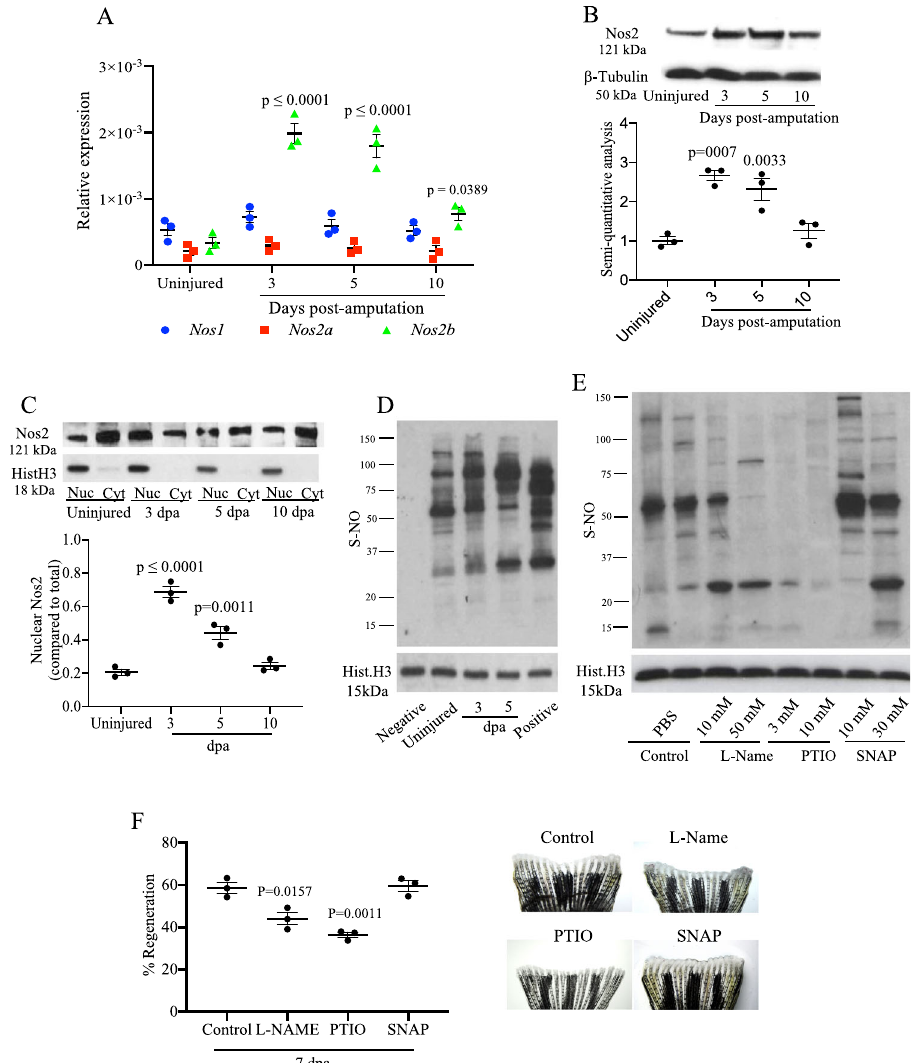
Fig. 1 Modulation of Nos and nuclear protein S-nitrosylation during tail fi n regeneration in adult zebra fi sh. A Real time PCR for nos1 , nos2a , and nos2b in tail fi n at 3, 5, and 10 dpa. B Western blot (WB) analysis of Nos2 in tail fi ns at 3, 5, and 10 dpa and semi-quantitative analysis of bands. C WB analysis of Nos2 in nucleus and cytoplasm of tail fi ns at 3, 5, and 10 dpa. Semi-quantitative analysis of bands shows nuclear to cytoplasmic protein ratio. D WB analysis of S-nitrosylated nuclear proteins in the regenerating tail fi n. S-nitrosothiols were speci fi cally labeled with TMT. An anti-TMT antibody was used to detect S-nitrosylated proteins. Neg and Pos are respectively the negative (without ascorbic acid) and positive (with S-nitrosoglutathione) controls. E , F WB analysis of S-nitrosylated nuclear proteins in tail fi n following treatment with L-NAME 10 or 50 mM, 2-Phenyl-4,4,5,5-tetramethyl imidazoline-1-oxyl 3-oxide (PTIO) 3 or 10 mM, S-Nitroso-N-acetyl- DL -penicillamine (SNAP) 10 or 30 mM, or PBS (control). The dot plot shows changes in tail fi n regeneration rate, here shown at 7 dpa, following drug treatments compared to control. β -tubulin was used as loading control for total or cytoplasmic proteins. Histone H3 was used as loading control for nuclear proteins. Dpa days post-amputation. N = 3 biological replicates, one way ANOVA test followed by Bonferroni ’ s multiple comparisons test was used to compare the means, p values shown are vs. uninjured or control, all other comparisons are not signi fi cant. Data are presented as mean values + / −